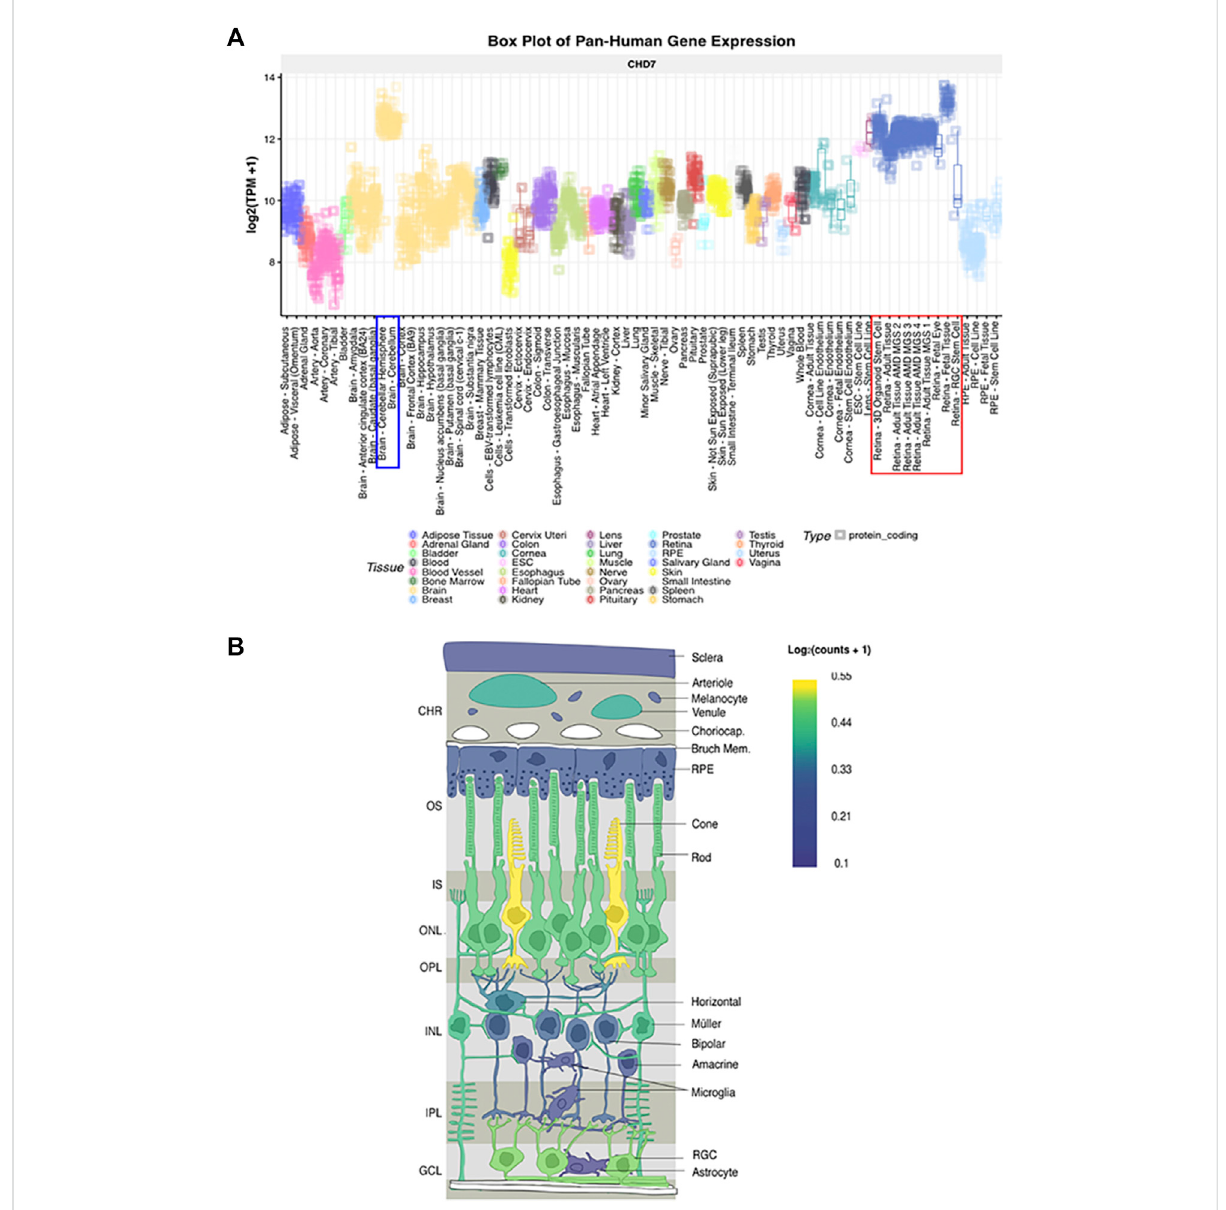
FIGURE 5 CHD7 expression in human retina (A) Box plot of pan-Human CHD7 expression in fetal and adult retinal tissue (red outline) compared to other tissues, assembled with the eyeIntegration v1.05 platform (Bryan et al., 2018). (B) In-situ projection from published human single cell RNAseq datasets. Assembled with PLatform for Analysis of scEiad (Swamy et al., 2021). Expression is highest in cones, rods, and retinal ganglion cells with lower expression in Müller glia. Reprinted with permission from (Krueger et al.,